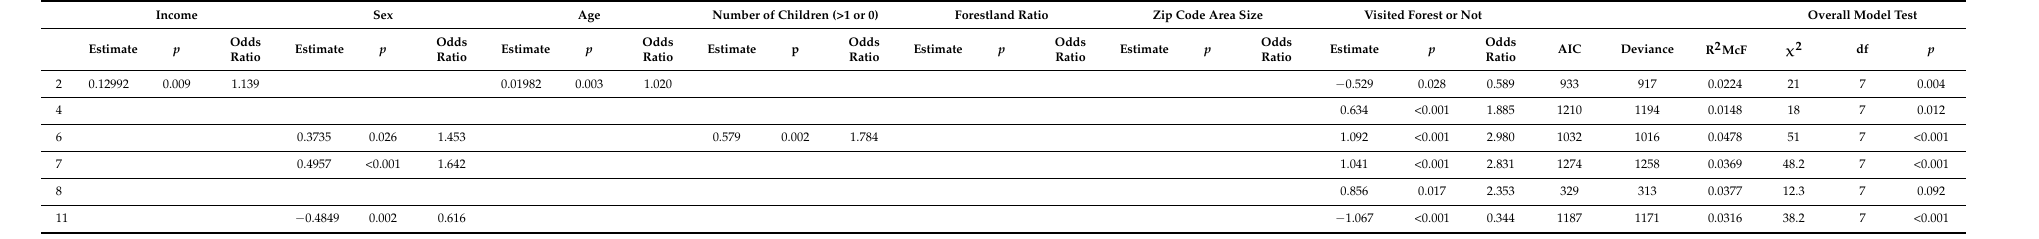
Table 4. Results of logistic regression analysis on the awareness of forestland functions: after the emergency